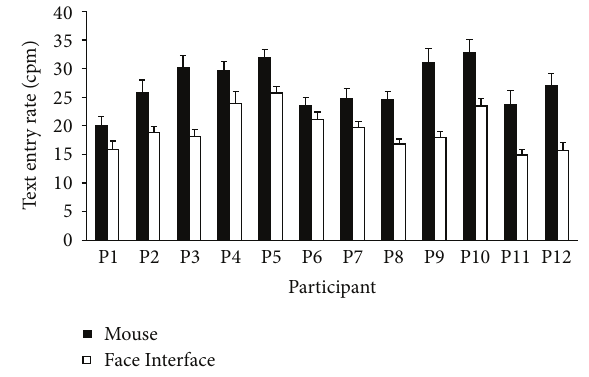
Figure 9: Text entry rate for both pointing devices divided by